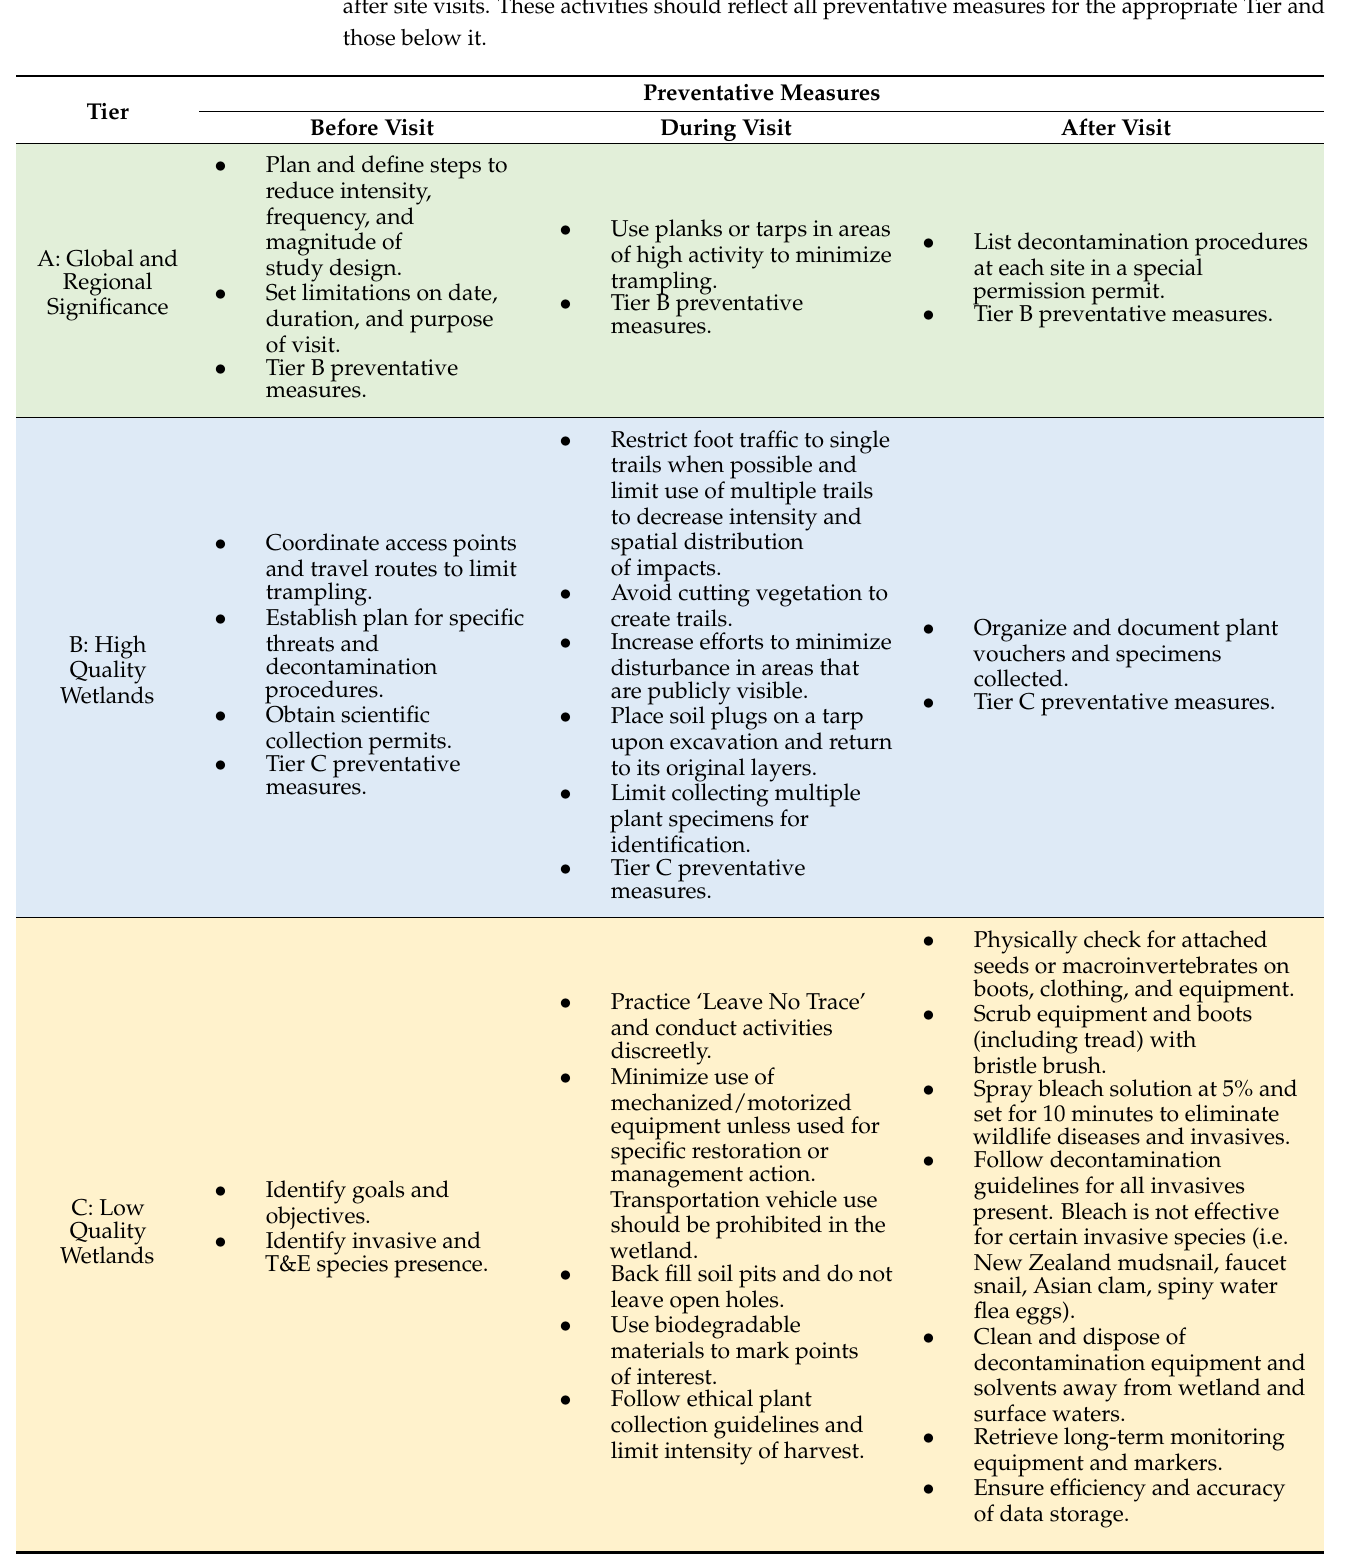
Table 3. Managers and researchers should coordinate procedures for all activities before, during, and after site visits. These activities should reflect all preventative measures for the appropriate Tier and those below